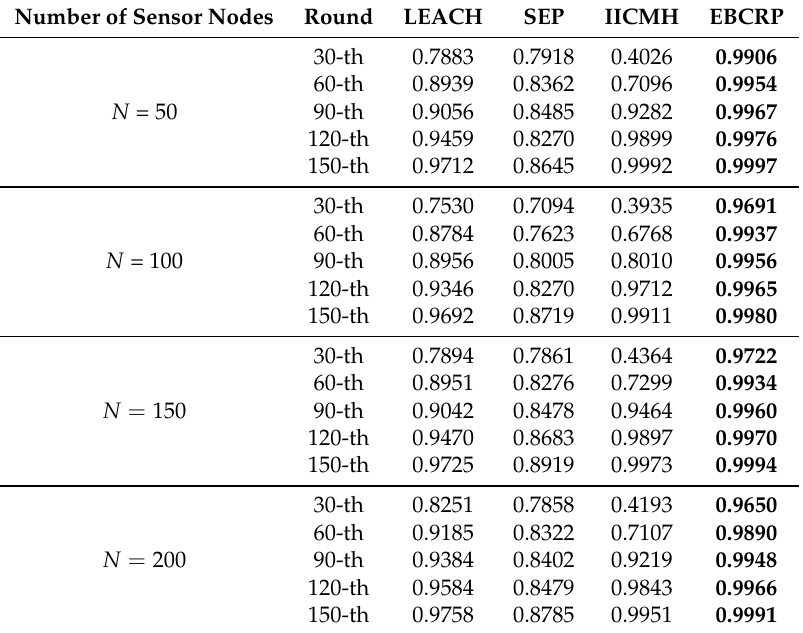
Table 3. The comparison of energy consumption balance index of different